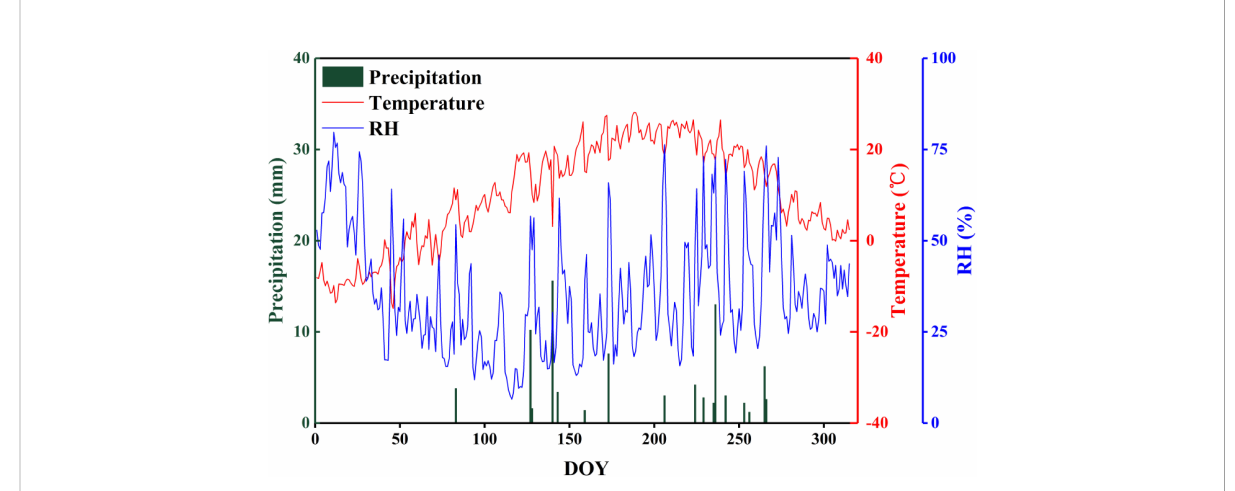
FIGURE 1 The distribution of monthly precipitation, temperature, and relative humidity during 2020 at the experimental site in the Badain Jaran